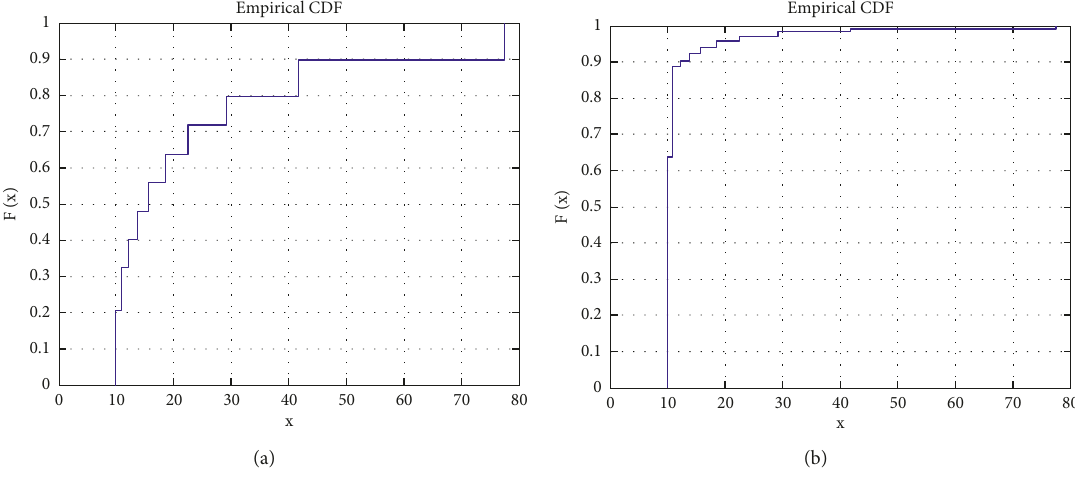
Figure 11: Cumulative curve of average bus fuel consumption. (a) Cumulative curve of average bus fuel consumption in Group A. (b) Cumulative curve of average bus fuel consumption in Group B. Table 2: Average bus fuel consumption in Group A and Group B.